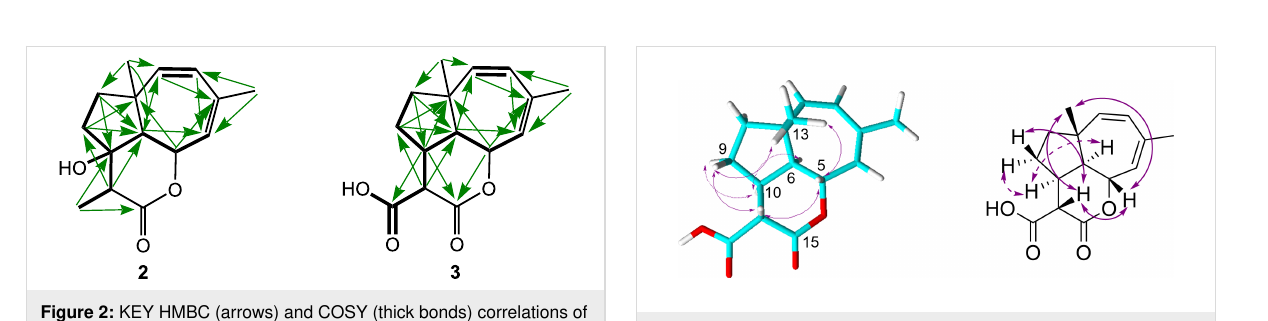
Figure 3: Key ROESY correlations of metabolite 3 .